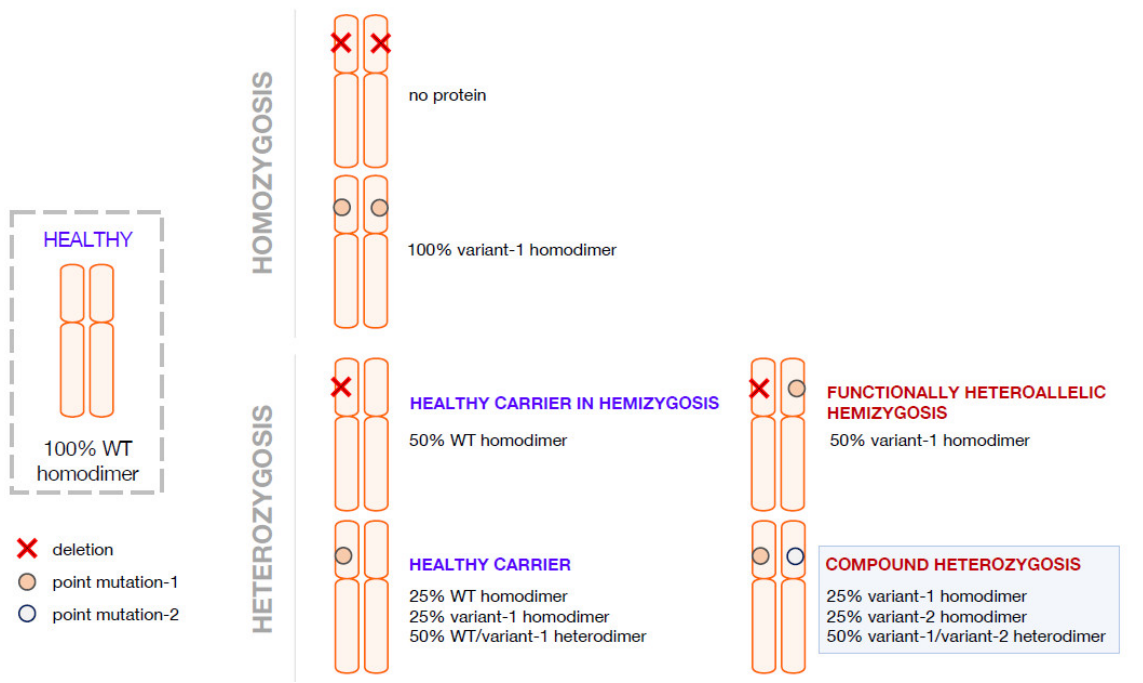
Figure 2. Possible combination of alleles in AADC deficiency in homozygosis and in heterozygosis. Representation of possible allele combination in healthy, homozygous and heterozygous conditions is drawn. In blue are the supposed healthy individuals or theoretical healthy carriers; in red, the affected individuals.